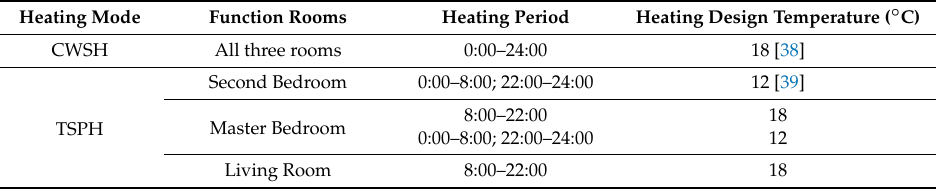
Figure 3. Logical diagram of the system running control. ( a ) TSPH system; ( b ) CWSH system. Table 3. Heating period and design temperature in the three rooms for the two